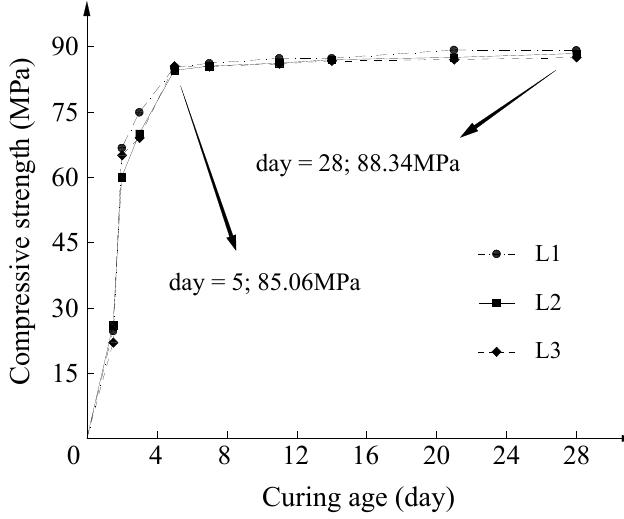
Figure 1. Compressive strength of resin concrete.